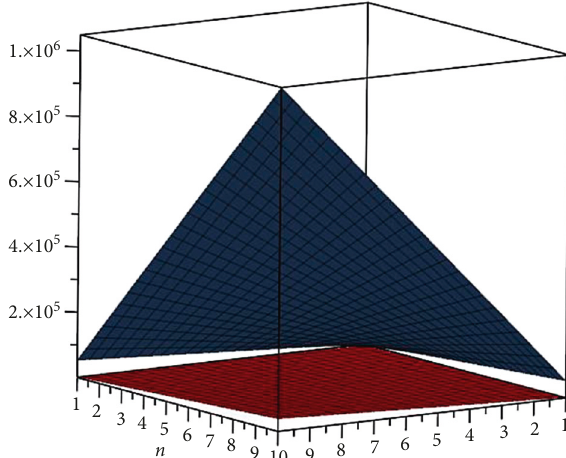
Figure 7: Graphical depiction of Table 7.